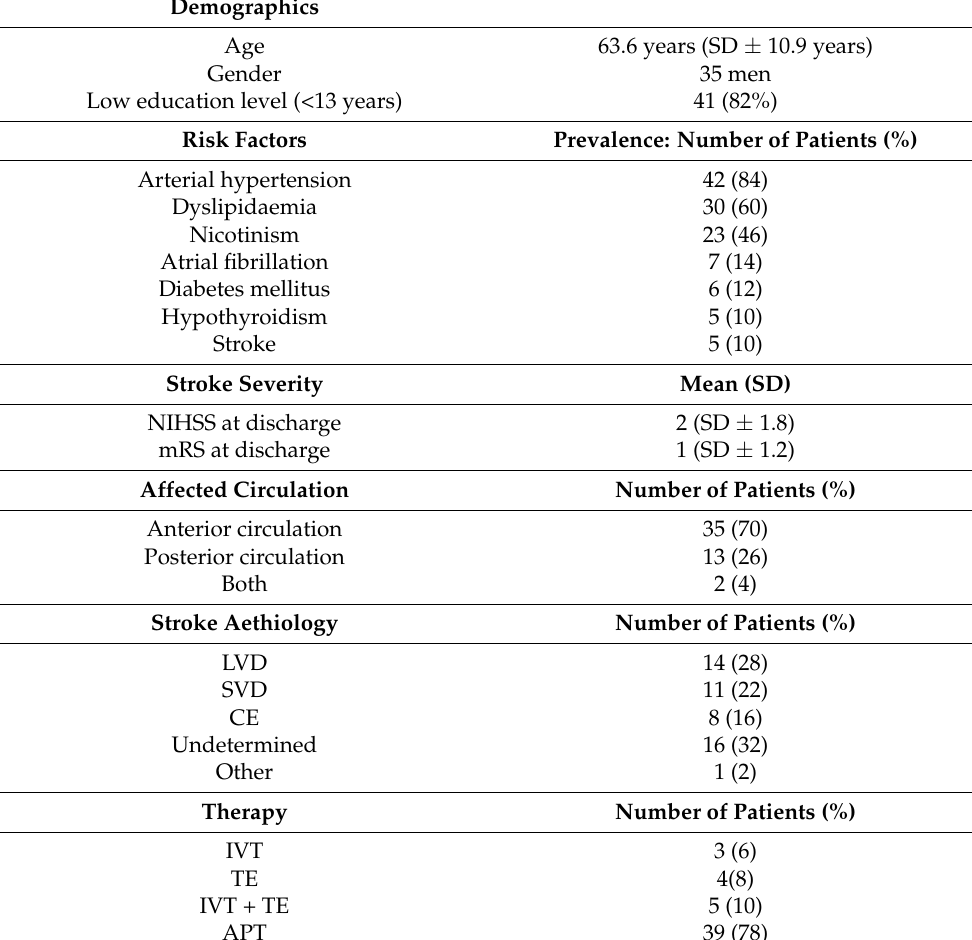
Table 1. Baseline characteristics of the analysed group (n =